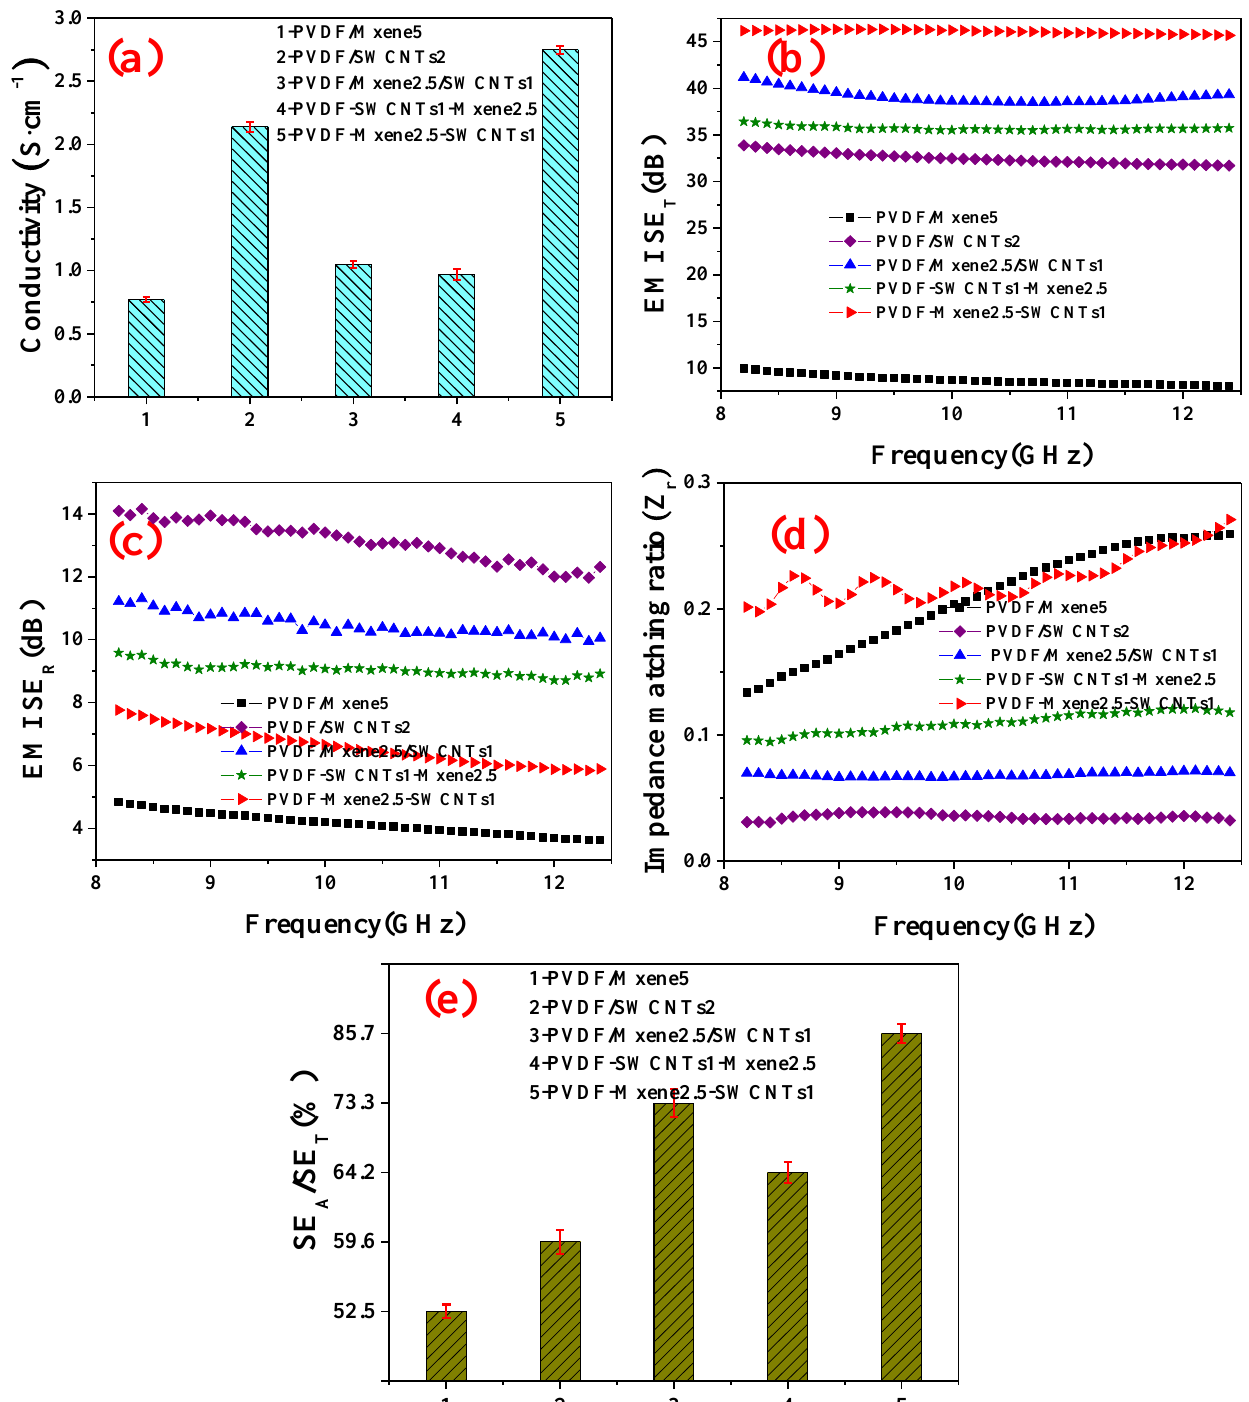
Figure 5. ( a ) Conductivity; ( b ) EMI SE T ; ( c ) EMI SE R ; ( d ) impedance matching ratio and ( e ) EM shielding absorption coefficient (SE A /SE T ) of PVDF/MXene5, PVDF/SWCNTs2, PVDF/MXene2.5/SWCNTs1, PVDF-SWCNTs1-MXene2.5, and PVDF-MXene2.5-SWCNTs1. In addition, MXene increases the density of SWCNTs in layered fillings. Conse- quently, the conductivity (2.14 S cm −1 ) of PVDF-MXene2.5-SWCNTs1, which exceeded PVDF/SWCNTs, was at the maximum. In summary, the excellent conductivity of the PVDF-MXene2.5-SWCNTs1 composite is due to the continuous and complete conductive network formed by the SWCNTs in the layered segregated structure. However, the